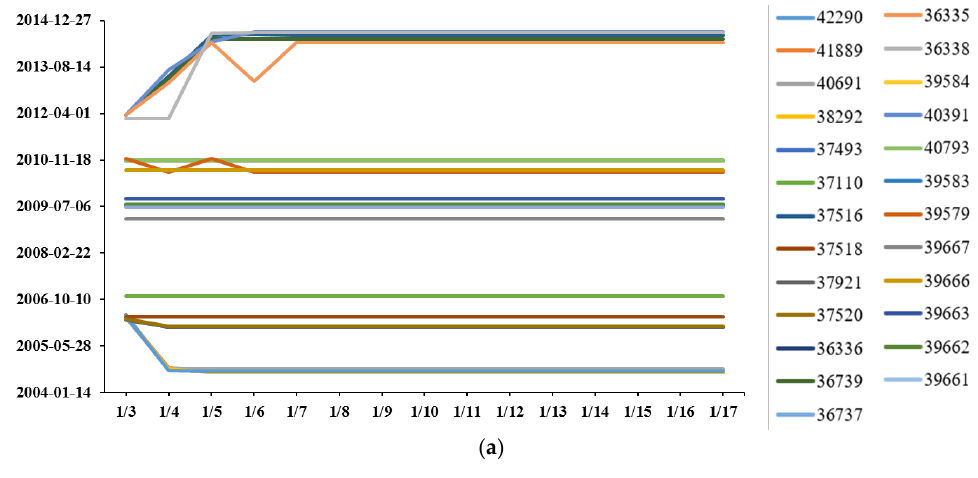
Figure 9. Landsat-8 OLI RGB synthesis image of Dahejia Reservoir with the MOD09A1 pixels in its range and the BFAST decomposition result of the pixel at the dam of it. The spatial extents of each MOD09A1 pixel was transparently shown as a chess board to illustrate that all of the pixels in Dahejia Reservoir are combined of different features, which obstructed the effectiveness of BFAST algorithm. When conducting the BFAST decomposition algorithm, the h parameter that indicates the sensitivity of the period of detected abrupt changes to the whole study period will influence the number and timing of break points (Figure 10a). We randomly sampled five pixels for each identified new reservoir and assessed the performance of BFAST algorithm affected by different settings of h parameter from 1/3 to 1/17. Using h = 1/5, where the minimum length of each trend segment is roughly 3.6 years, abrupt changes were not detected for Gongboxia Reservoir at the time of the recorded damming activities (between 2003 and 2005). Similarly, using h = 1/4, where the minimum length of each trend segment is approximately 4.5 years, abrupt changes cannot be detected effectively in Huangfeng Reservoir at the time of the recorded damming activities (around the year 2014). It suggests that the minimum intervals of breaks were too wide to accurately reflect damming activities over the period of satellite image time series. However, as the value of h decreases, the accuracy of breaks began to increase and became acceptable when it was set to 1/7, and then it would be generally stable till 1/17. The h parameter also has a great impact on the averages of trend components (refer to as “ATC” in abbreviation) before and after break points, which may greatly influence the effectiveness of the afore-mentioned threshold-based pixels with false break points elimination. We sampled 10 pixels in water area and 10 pixels in land area, and ATCs of the sampled 25 reservoir area pixels were also used. Note that most of the 20 pixels were sampled near the river, considering buffer would be introduced to eliminate unfiltered pixels with false break points. Among the land-to-water pixels, when h was set to 1/3, their ATCs before and after break points may be far away from stable values, but when it was set to 1/7, ATCs would be generally stable and when it was set to 1/10 or smaller, every single pixel’s ATCs would equal each other, which was shown in Figure 10b and 10c. ATCs of water area pixels after break points and ATCs of land area pixels before and after break points are generally stable, but ATCs of water area pixels before break points would suddenly drop when h was changed from h = 1/10 to h = 1/11. From the ATC plots of all kinds of pixels in Figures 10b and 11, all of the sampled pixels’ ATCs derived from different settings of h parameter varying from 1/3 to 1/17, except three pixels’ ATCs when h parameter was set to 1/3, perfectly suit the −0.2 threshold and would be classified into classes they belong to. This indicates that the effectiveness of the threshold which equals to −0.2 is robust enough to be less sensitive to different settings of h parameter. So a likely effective approach to increase the accuracy of breaks detected in newly dammed reservoirs whose timing of damming activities are close to the end or beginning of time series period is to lower the value of h parameter such as one or two-year period (h ~ 0.10–0.05), and it would not greatly influence the accuracy of newly-dammed reservoir